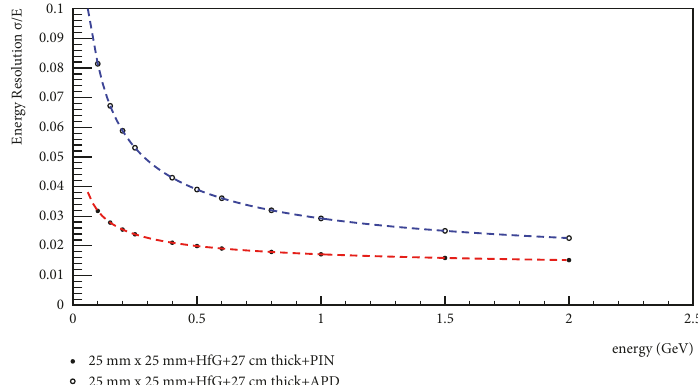
Figure 8: Parameterized energy resolution function (dashed lines) and energy resolution values at certain energies (points) for scintillator- photodetector combinations belonging to HfG with 25 mm x 25 mm back face area and 27 cm thickness.